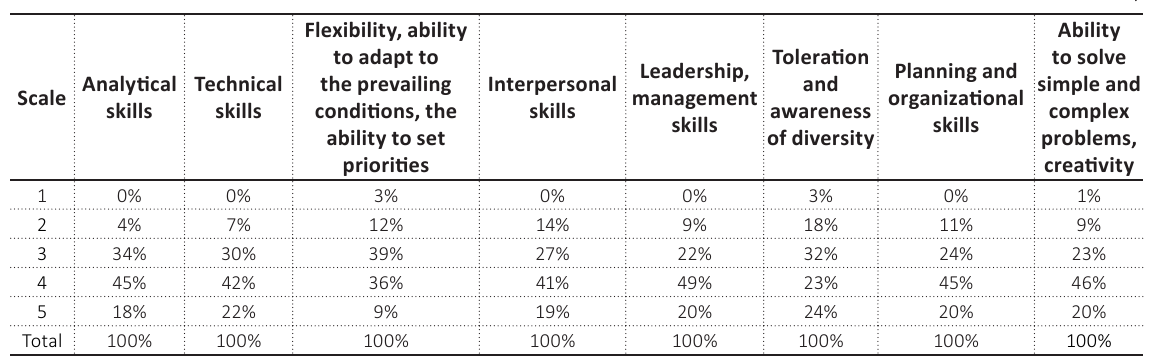
Table 9. Aggregated components of competencies of the employees